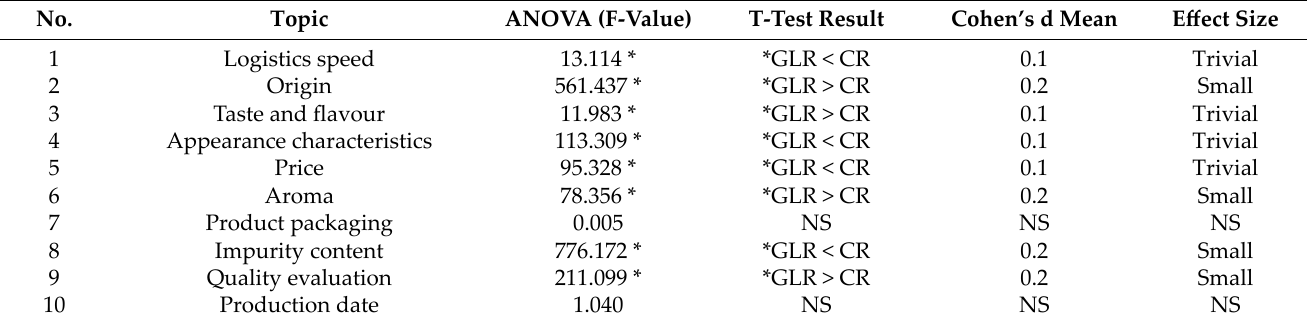
Table 4. Comparison of Green‑Labelled Rice (GLR) and Conventional Rice